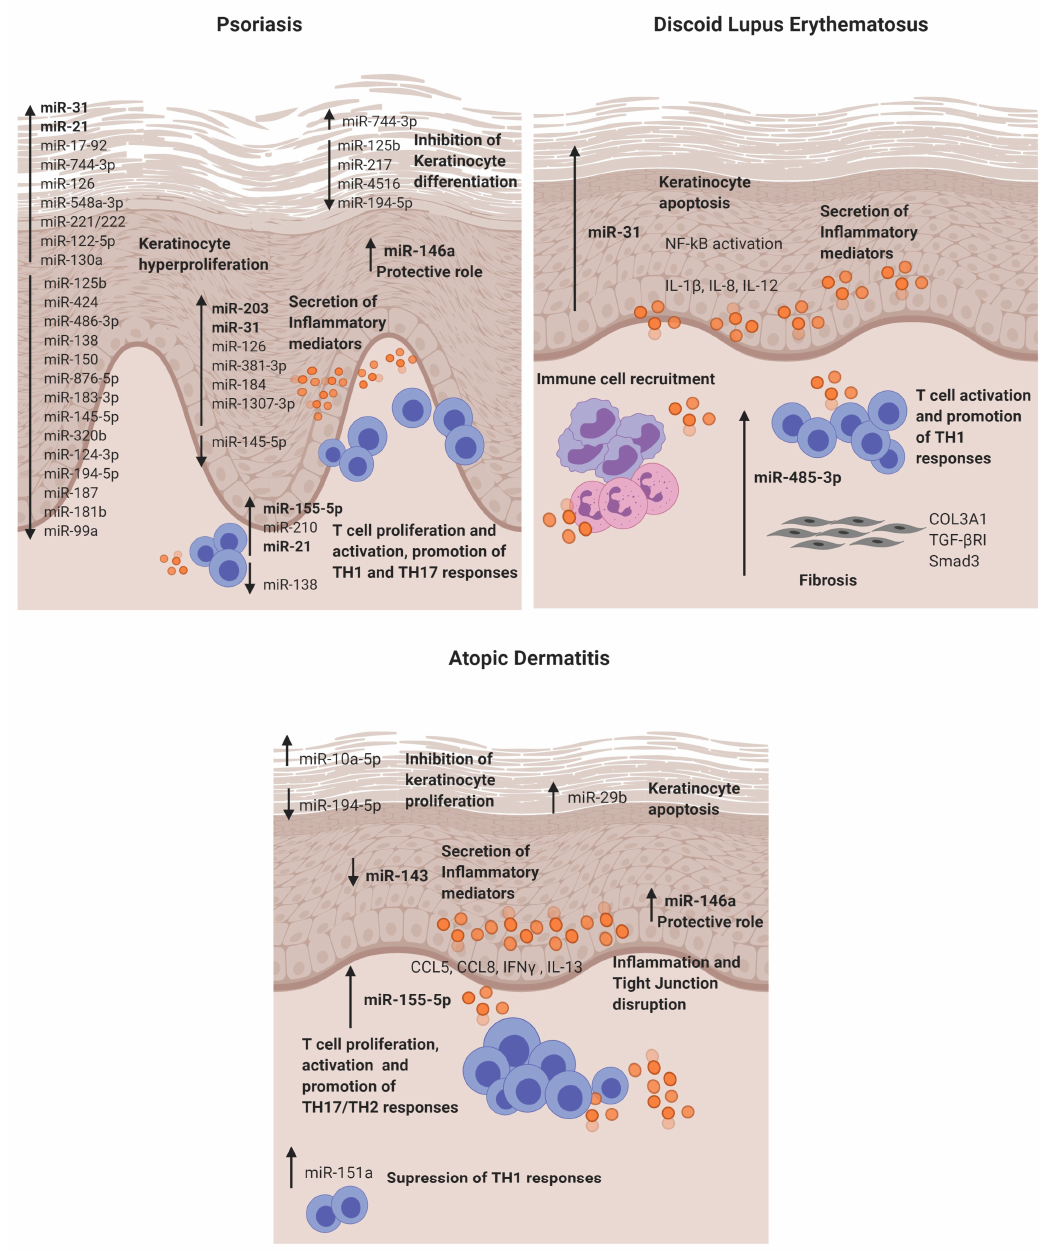
Figure 2. Dysregulated miRNAs involved in Psoriasis, discoid lupus erythematosus and atopic dermatitis and their roles in the disease pathogenesis. DLE: discoid lupus erythematosus and AD: atopic dermatitis.